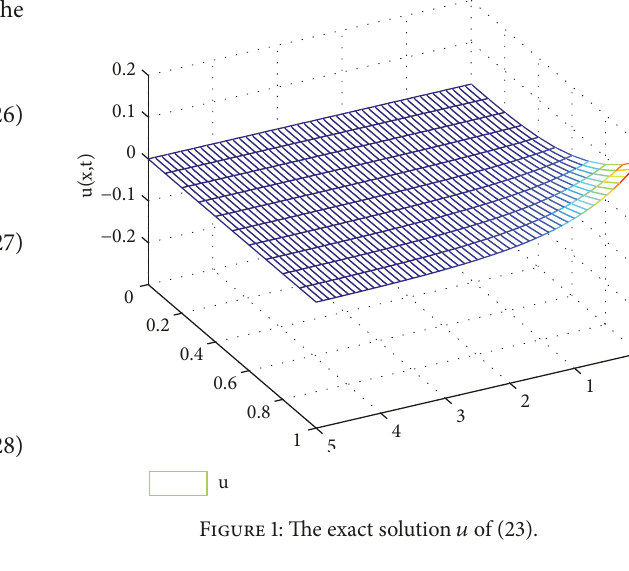
Figure 1: The exact solution 𝑢 of (23).